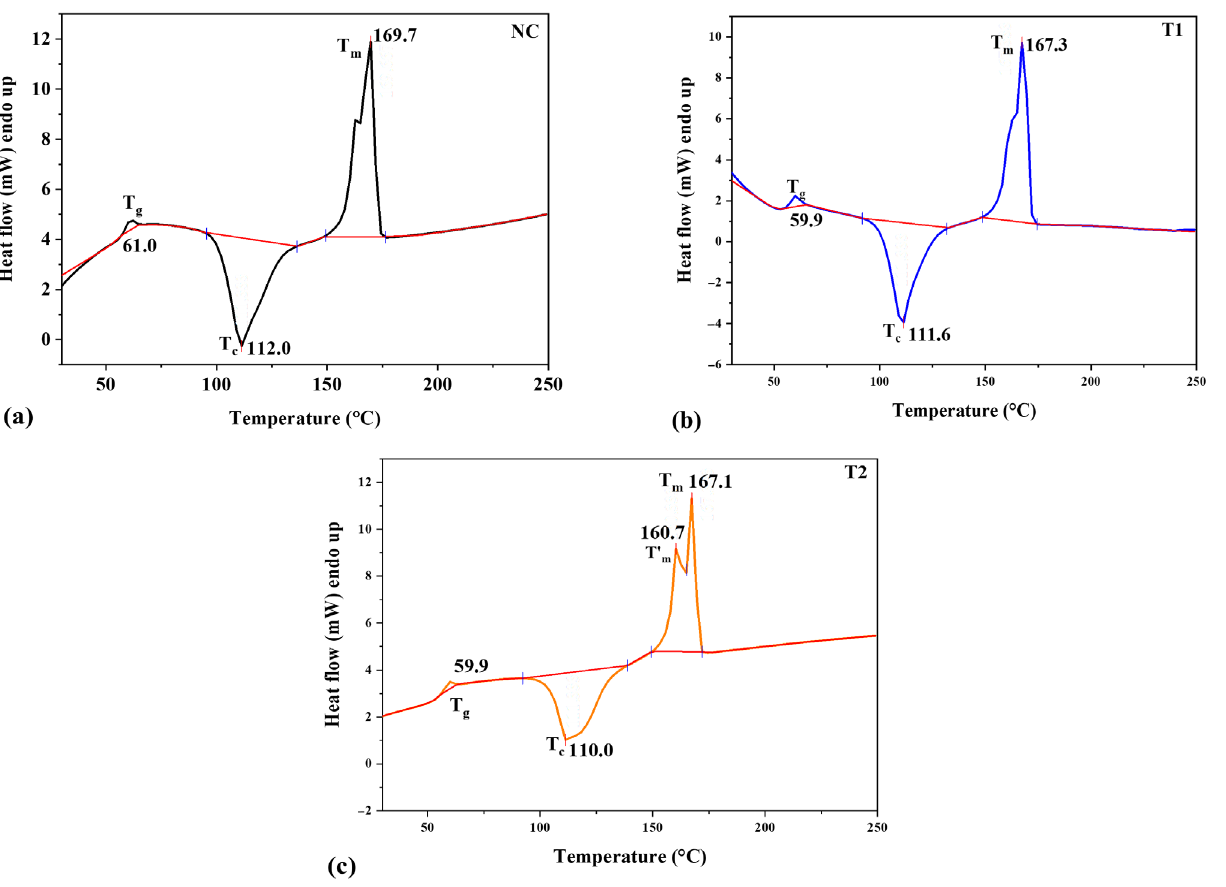
Figure 7. DSC heating curves of ( a ) NC nanocomposite without compatibilizer, and ( b ) T1 and ( c ) T2 systems with compatibilizers at a ratio of 1:1 compatibilizer to nanofiller. Table 3. DSC and crystallinity percentage of compatibilized conductive nanocomposite system.